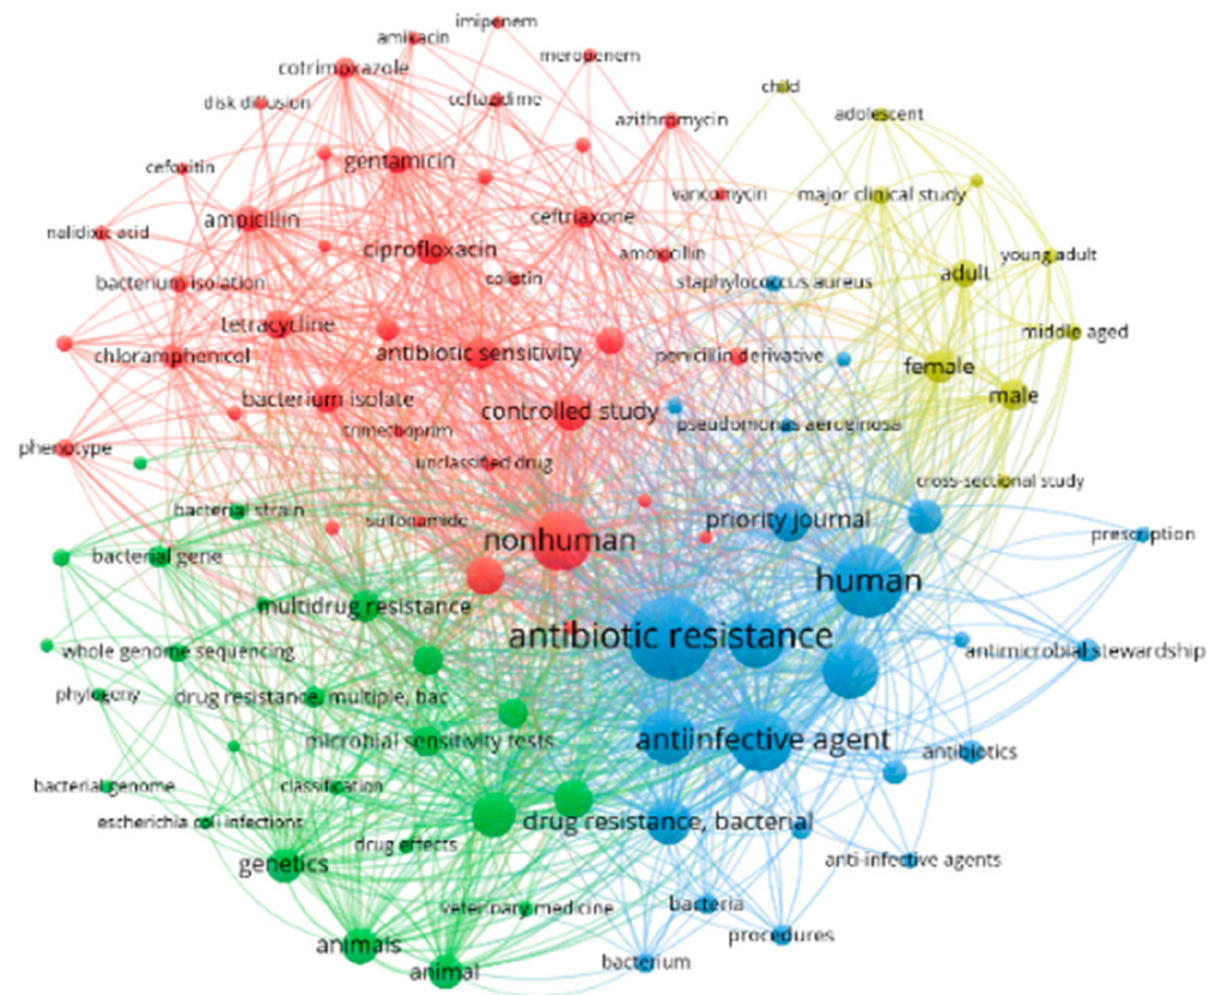
Figure 4. Network visualization map of top 100 most frequently used terms in the retrieved AMR-related publications